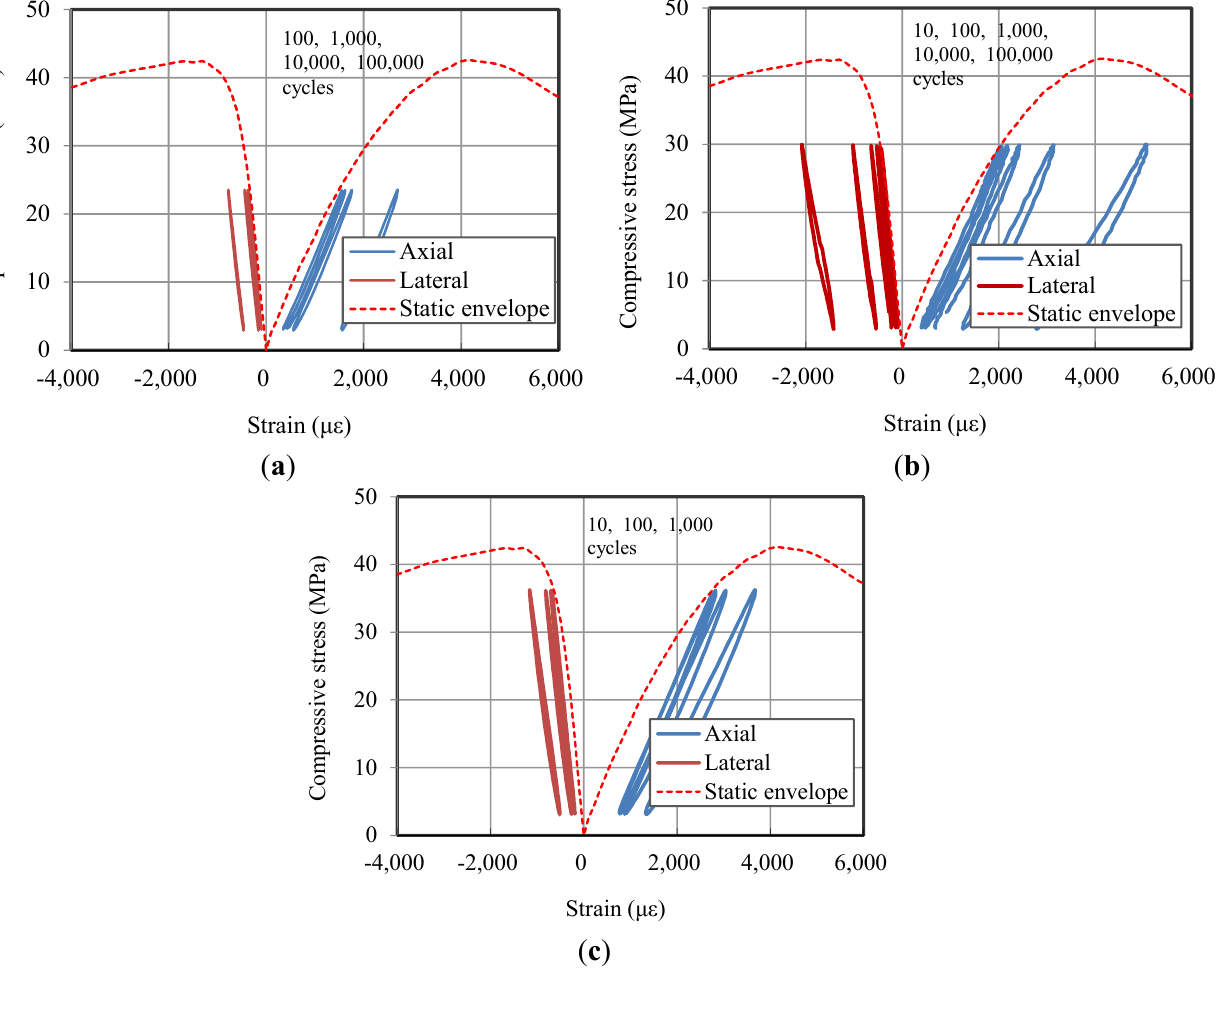
Figure 7. The compressive axial and lateral behavior of HPFRCC under repeated loading conditions: ( a ) the result of the 55% specimen; ( b ) the result of the 70% specimen; and ( c ) the result of 85%